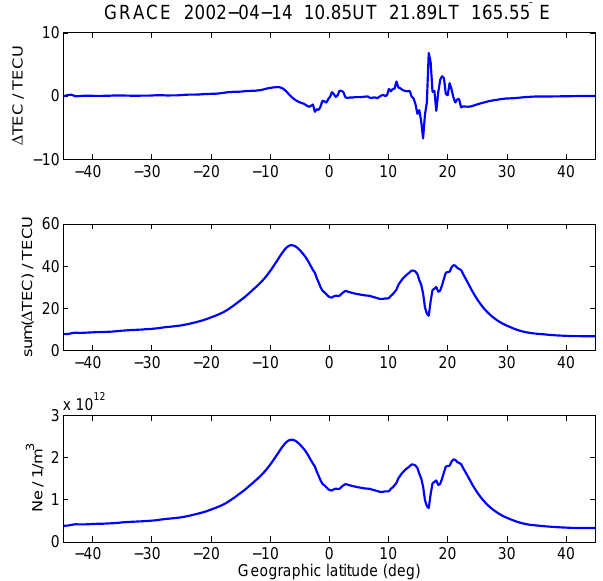
Fig. 2. Example of KBR1B data on 14 April 2004; 1 TEC (top panel), sum 1 TEC (middle panel) and average electron densitybe- tween GRACE-A and GRAC-B satellites (bottom